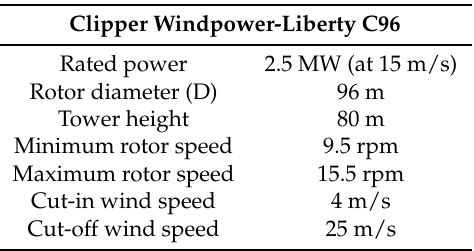
Table 1. Wind turbine main characteristics.